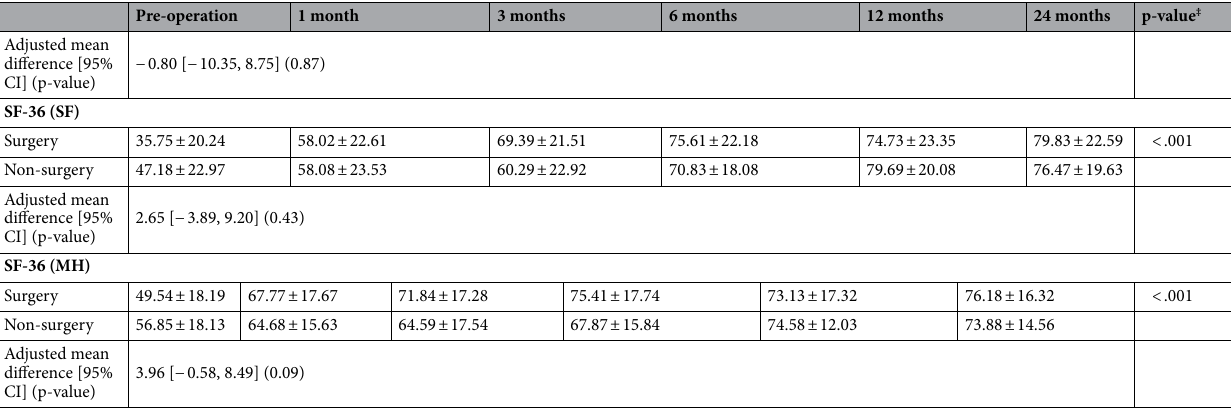
Table 3. Clinical outcomes. VAS-B visual analogue scale for back pain, VAS-L visual analogue scale for leg pain, K-ODI Korean version of the Oswestry Disability Index, EQ-5D score EuroQol 5-Dimension instrument score, EQ-VAS EuroQol visual analogue scale, SF-36 36-Item Short-Form Health Survey. The results from the linear mixed effects model (*adjusted mean difference between surgery and non-surgery cohort, confidence intervals are represented according to statistical significance; †cohort difference; ‡ time difference). †† The